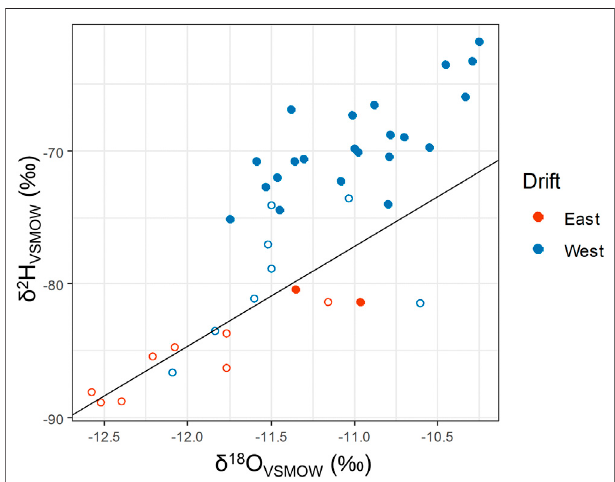
FIGURE 4 | Water isotopes of Soudan borehole samples. Filled circles represent samples taken from boreholes drilled at a downward angle relative tothemine fl oor,whileopencirclesrepresentsamplesdrilledatahorizontalor upward angle. The black line shows local meteoric water regression calculated from Ely, MN, United States precipitation sampled between April and November 1996.